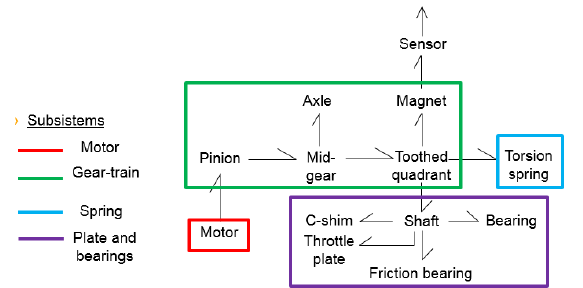
Figure 4. Word model of the ACV